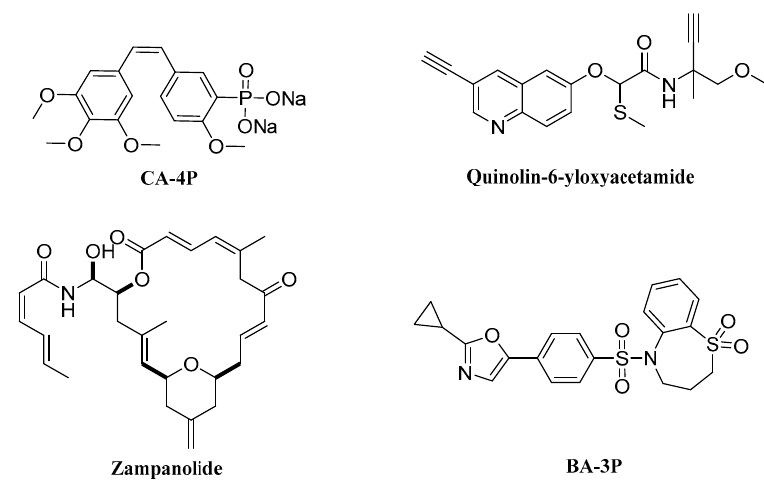
Figure 1. Potent tubulin-targeting agents.